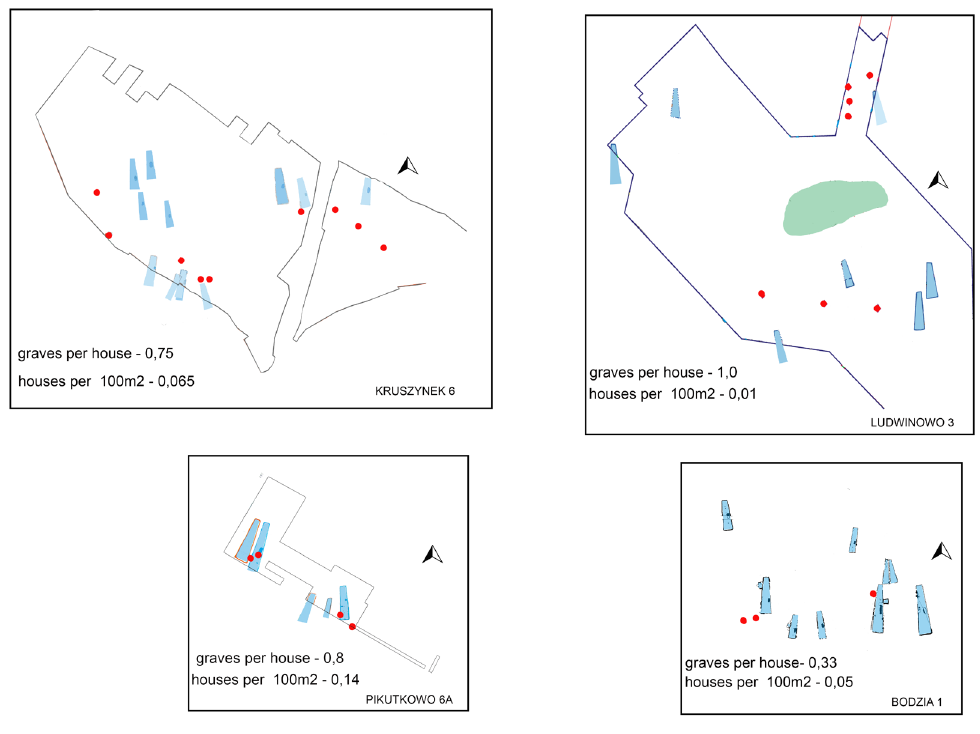
Fig. 4. Houses and graves on BKK settlements at Kruszynek 6, Ludwinowo 3, Pikutkowo 6a and Bodzia 1. According to: Siewia- ryn 2010; Marchelak et al. 2012; Grygiel 2008; Czerniak 2012b, modified by the authors.